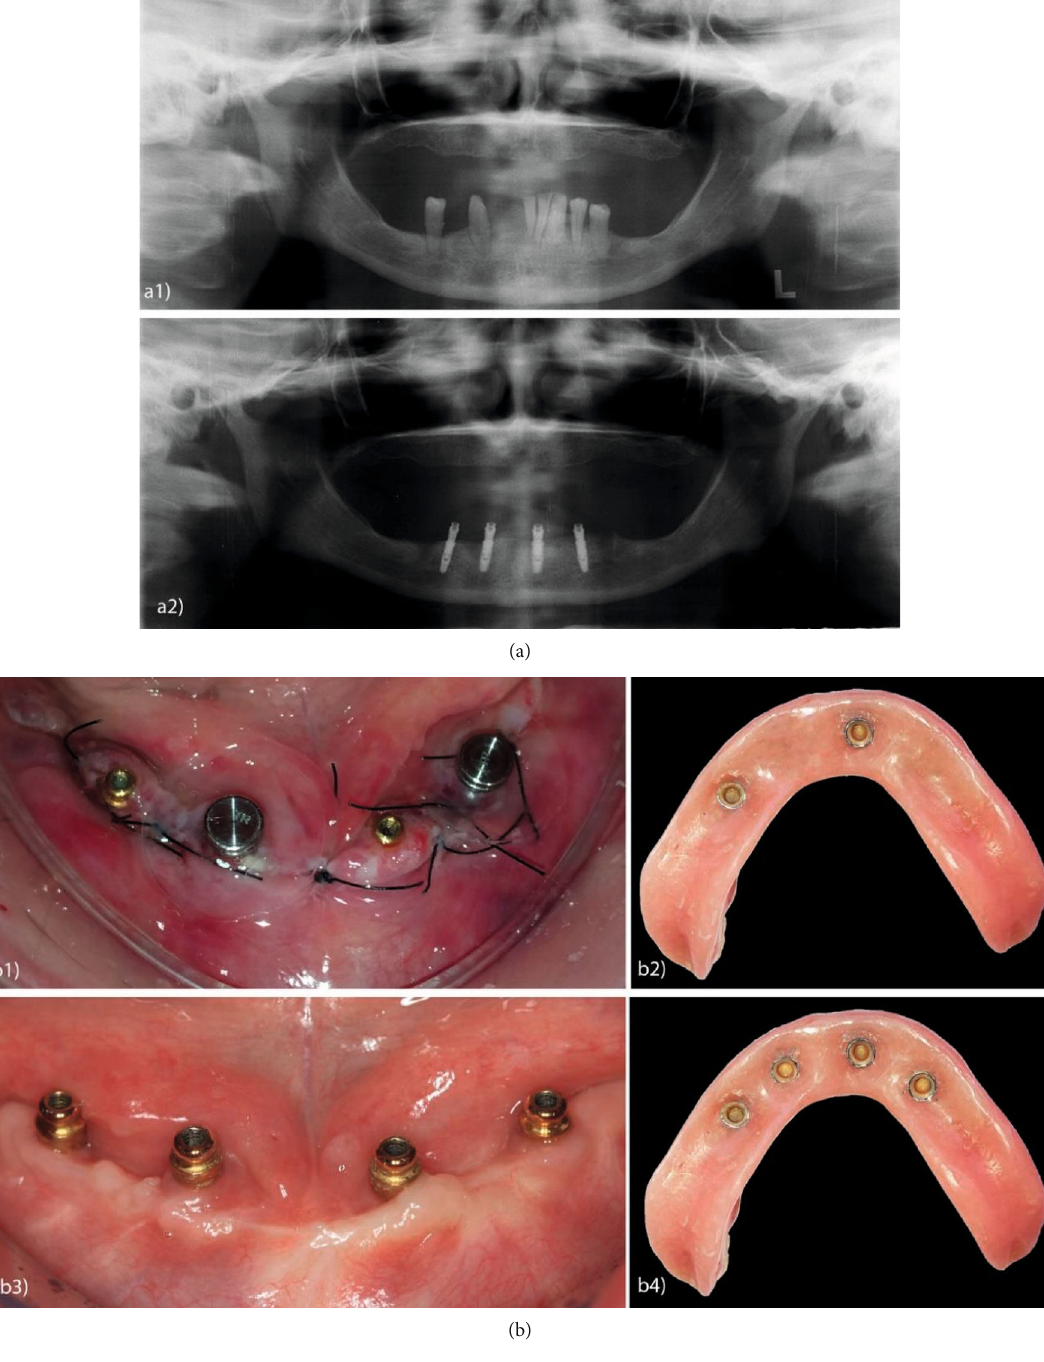
Figure 6: : (a) Panoramic X-rays: (a1) preoperative and (a2) immediate postoperative; (b) hybrid occlusal loading: (b1) occlusal view of the O- rings with cylinders in position for capture; (b2) view of the prosthesis base after capturing the O-rings with cylinders of implants 2 and 4; (b3) occlusal view of the attachments prior to capturing implants 1 and 3; (b4) view of the prosthesis base after fi nal